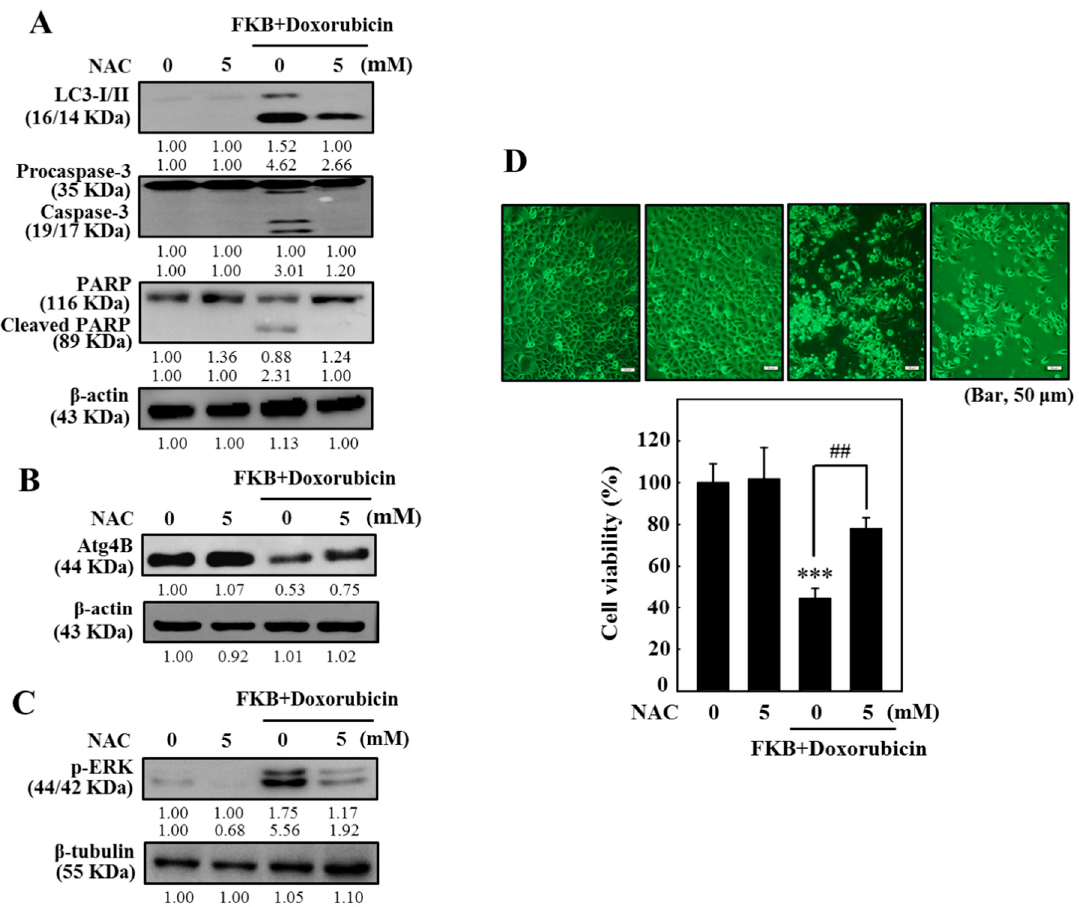
Figure 10. In AGS cells, ROS induced by FKB + doxorubicin is mediated-apoptosis and autophagy. Cells were pretreated for 1 h with an ROS inhibitor (NAC, 5 mM), and co-treated with FKB (2.5 µ g / mL) and doxorubicin (0.5 µ g / mL) for 24 h. ( A ) Western blot monitors the terms caspase-3, PARP, and LC3-I / II (Figure S8A). ( B , C ) Western blot was monitored for the terms ATG4B and p-ERK (Figure S8B,C). ( D ) The MTT assay was used to assess cell viability. Values were expressed as mean ± SD ( n = 3). Significant at *** p < 0.001 compared to untreated control cells. Significant at ## p < 0.01 compared to FKB-treated cells.